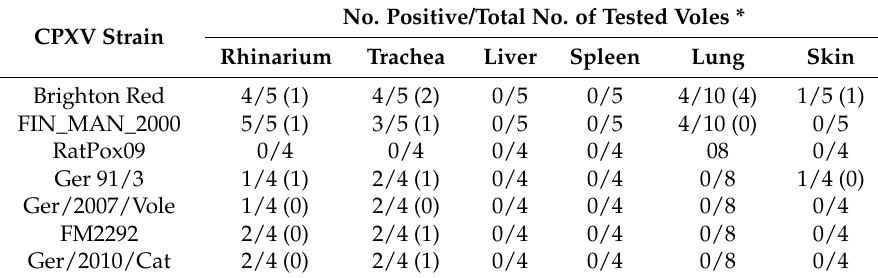
Table 4. Viral DNA detection in different organs at 5 dpi.